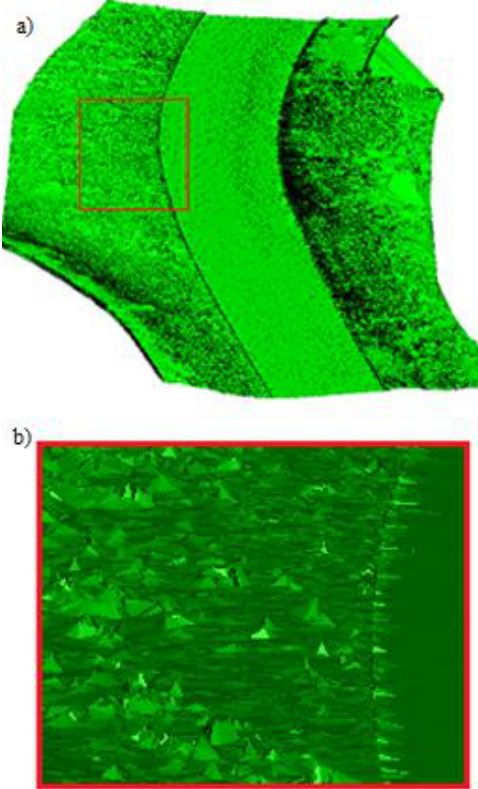
Figure 12. a) Hill shade representation of the Delaunay triangulation of Figure 8a) result b) Amplified red area of Figure 12a).